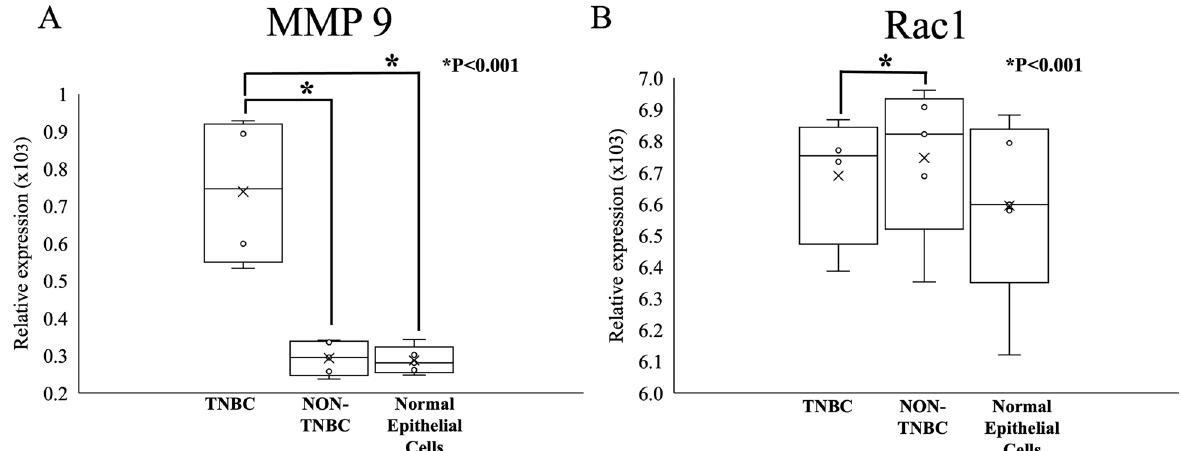
Fig. 5 Analysis of Hsd interactors in TNBC by Microarray data analysis. A MMP 9 expression. B Rac1 expression. Gene expression data were collected from the GEO datasets. * p < 0.05 (the Kruskall-Wallis test) was considered statistically